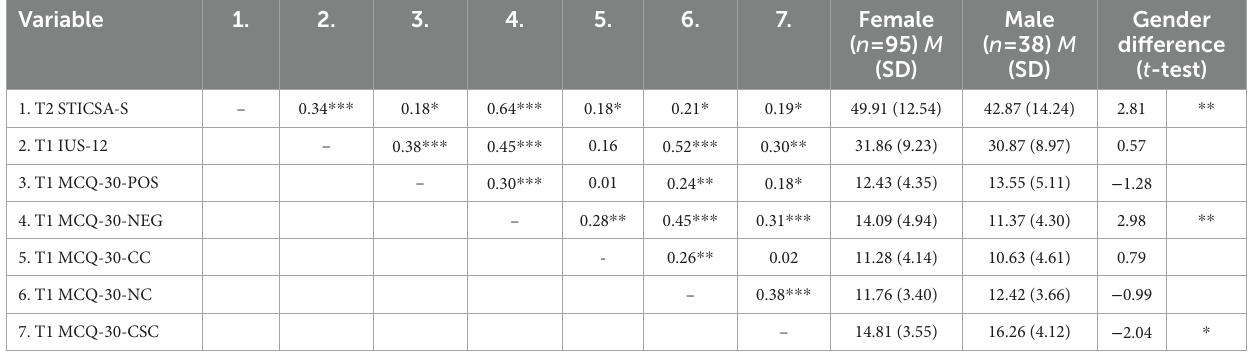
TABLE 2 Descriptive statistics, zero-order correlations between study variables. Variable